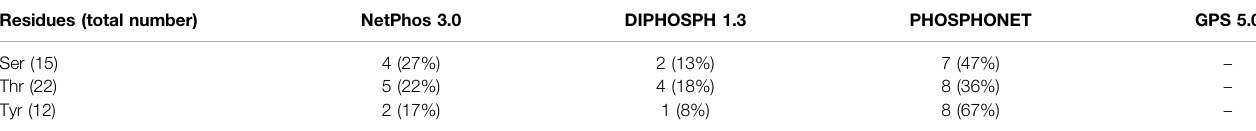
TABLE 2 | Prediction of phosphorylation sites in hDAAO by using web-based tools. For netPhos 3.0 prediction, the score value was set above